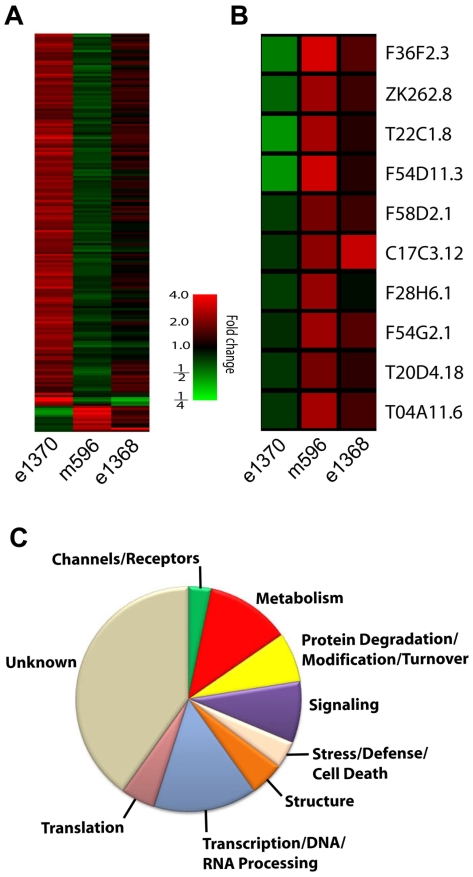
Expression of 182 genes are differentially regulated across daf-2 alleles.(A) Heat map of expression of 182 genes, either up- or down-regulated between e1370 and m596 and/or e1368, p<0.01, One-Way ANOVA. (B) Genes whose expression is downregulated in e1370 (die) relative to m596 and/or e1368, p<0.01. (C) Relative number of daf-2 regulated genes that fall into the various functional categories.